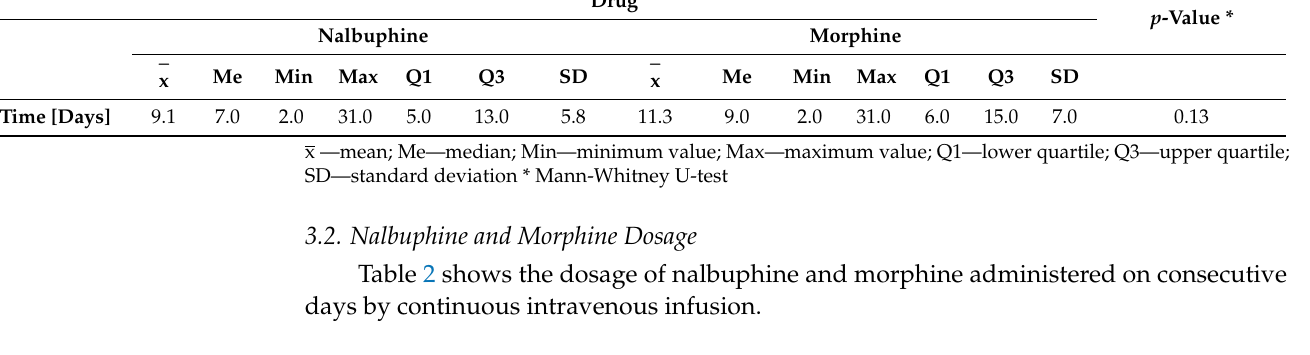
Table 2. Comparing nalbuphine and morphine dosing by continuous intravenous infusion on consecutive days of